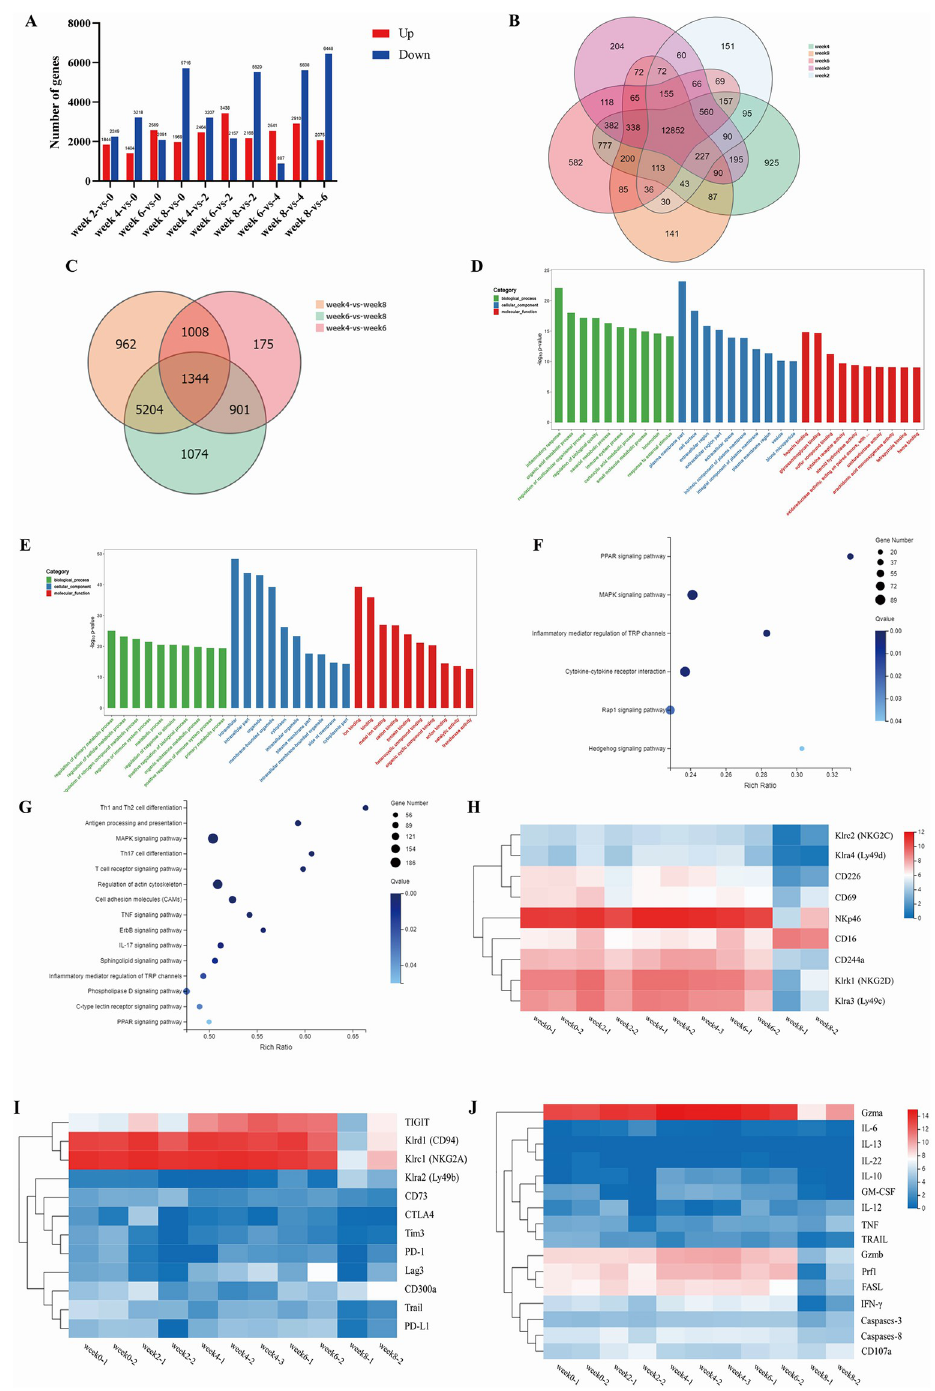
Fig 1. Analysis of natural killer (NK) cell transcriptome sequencing data. (A) Differentially expressed genes (DEGs) at different time points after infection. (B) Venn diagram showing DEG overlap between the two groups at 0, 2, 4, 6, and 8 weeks post infection. (C) Venn diagram showing DEG overlap between the two groups at the 4, 6, and 8 weeks post infection. (D) Bar graphs of gene ontology (GO) enrichment of DEGs common between 6 weeks and 4 weeks post infection. (E) Bar graphs of GO enrichment of DEGs common between 8 weeks and 6 weeks post infection. (F) Bubble plots of Kyoto Encyclopedia of Genes and Genomes (KEGG) pathway enrichment of DEGs common between 6 weeks and 4 weeks post infection. (G) Bubble plots of KEGG pathway enrichment of DEGs common between 8 weeks and 6 weeks post infection. (H) Expression of NK cell activating receptors at different time points post infection. (I)